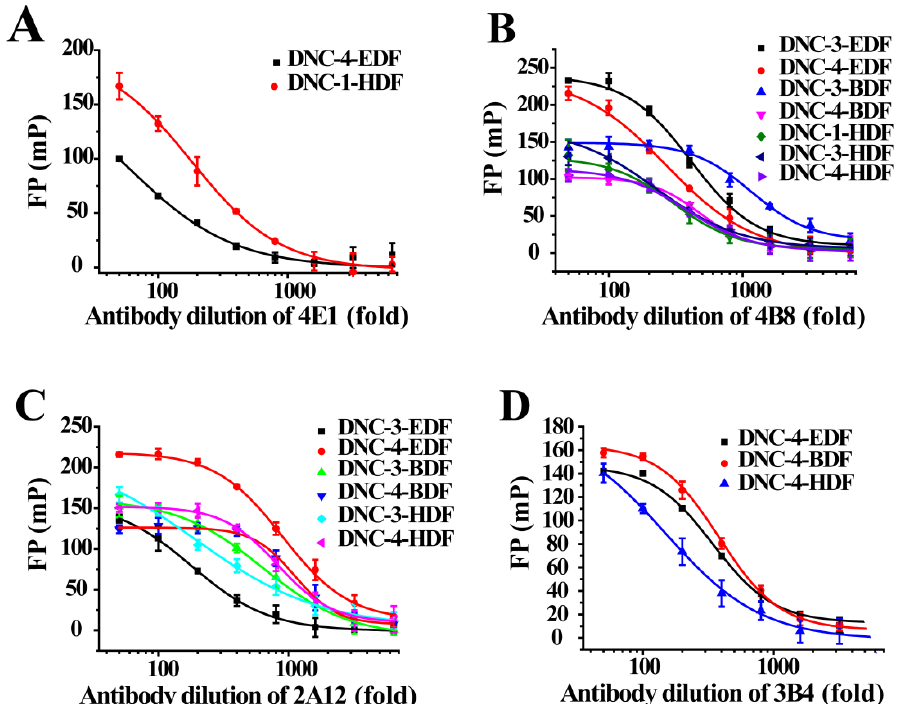
Figure 3. Antibody dilution curves of tracers. ( A ) 4E1 with DNC-4-EDF and DNC-1-HDF. ( B ) 4B8 with DNC-3-EDF, DNC-4-EDF, DNC-3-BDF, DNC-4-BDF, DNC-1-HDF, DNC-3-HDF, and DNC-4- with DNC-3-EDF, DNC-4-EDF, DNC-3-BDF, DNC-4-BDF, DNC-1-HDF, DNC-3-HDF, and